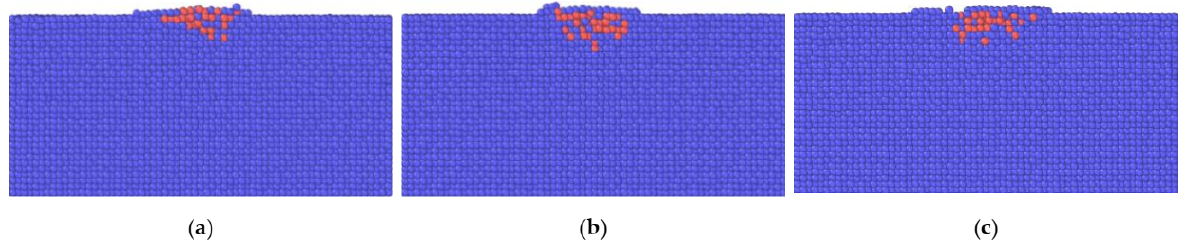
Figure 8. Morphology snapshots (side views of the center section along x–z plane) of Cluster 0 and substrate after impacting at the different T z ,0 in Model 1: ( a ) T z ,0 = 1 ev, ( b ) T z ,0 = 50 ev and ( c ) T z ,0 = 100 ev. In all cases, V z ,0 = 600 m/s and T x ,0 = 0 ev.